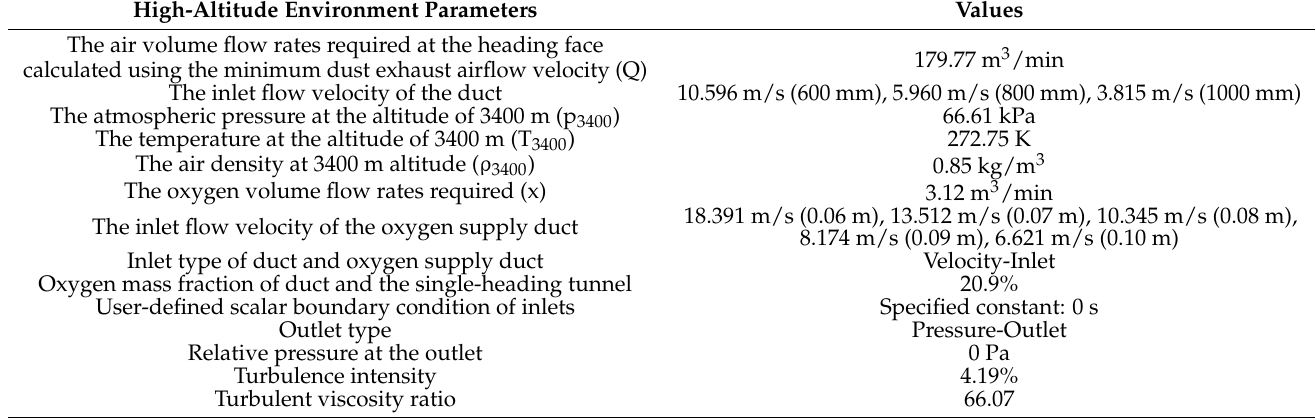
Table 2. The high-altitude environment parameters and boundary conditions of CFD